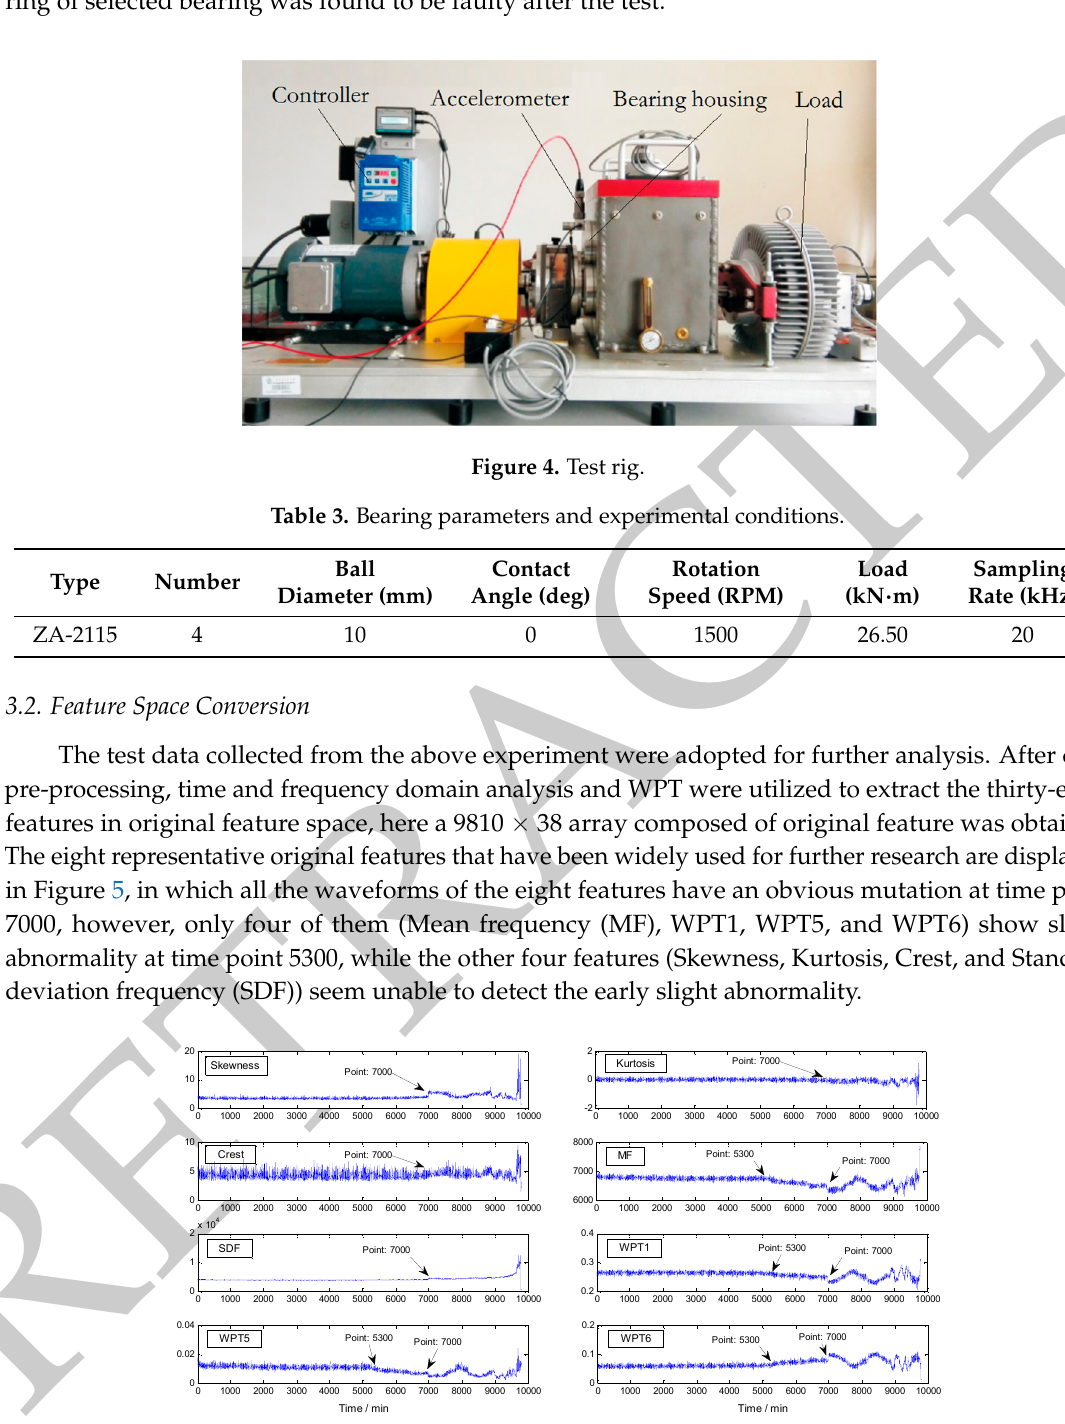
Figure 5. Eight of the features in original feature